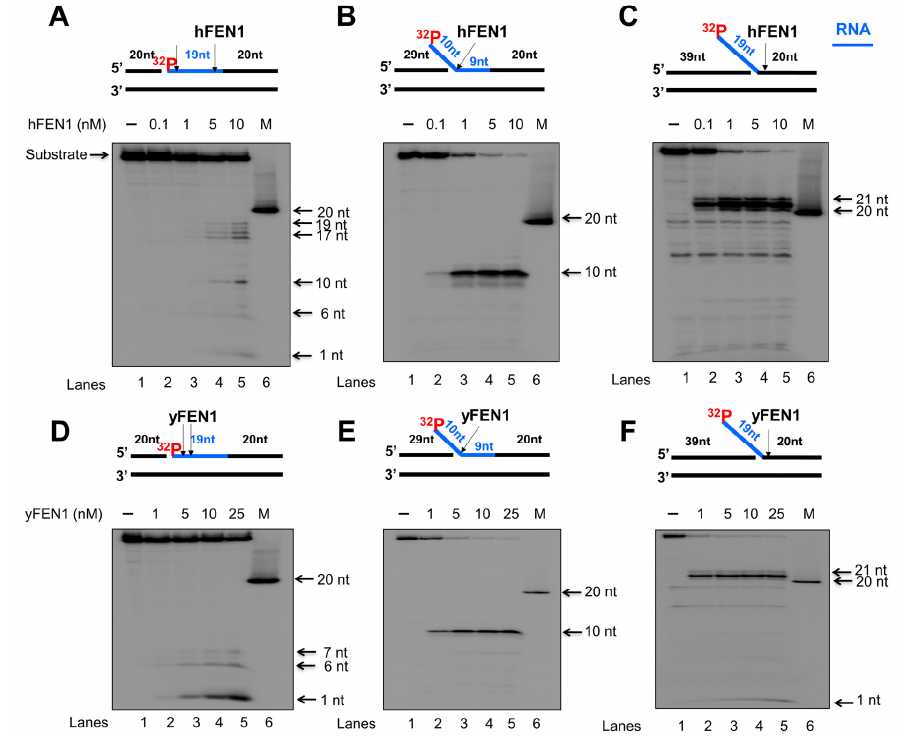
Figure 1. FEN1 endonucleolytic cleavage of an RNA strand in RNA:DNA hybrids. Human and yeast FEN1 cleavage activity on a RNA strand of RNA:DNA hybrid was measured by incubating different concentrations of FEN1 (0.1–25 nM) with the substrates (25 nM) that mimics the intermediates generated during DNA lagging strand processing. Substrates were radioactively labeled at the 5 ′ -end of the downstream strand containing an RNA (blue) and DNA (black) fragment on the same strand. ( A ) Human FEN1 cleavage on the nicked RNA:DNA hybrid substrate. ( B ) Human FEN1 cleavage on the RNA:DNA hybrid substrate intermediate containing a 9 nt-RNA flap. ( C ) Human FEN1 cleavage on the substrate containing a 19 nt-RNA flap attached to a duplex DNA. ( D ) Yeast FEN1 cleavage on the substrate containing a nicked RNA:DNA hybrid. ( E ) Yeast FEN1 cleavage on the substrate containing a 9 nt-RNA flap in a RNA/DNA hybrid. ( F ) Yeast FEN1 cleavage on the substrate containing a 19 nt-RNA flap attached to a duplex DNA. Lane 1 represents substrate only. Lanes 2–6 represent the reaction mixture with increasing concentrations of FEN1. “M” represents a size marker of 20 nt. Substrates and products were separated in a 15% urea-denaturing polyacrylamide gel and detected by phosphorimagery. All experiments were performed in